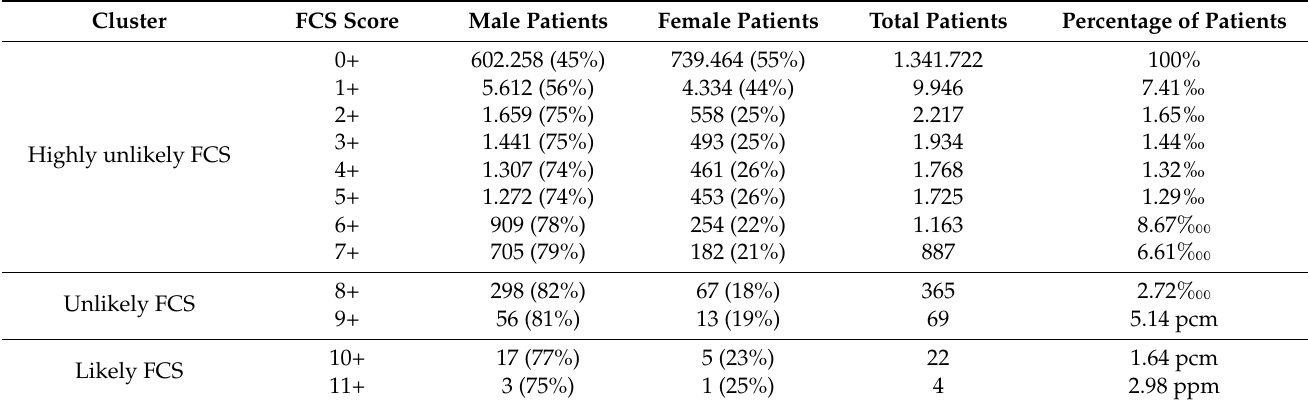
Table 3. Calculated familial chylomicronemia (FCS) scores of patients visiting medical providers in the Northern Great Plain area of Hungary (pcm = 1:100,000; ppm = 1:1,000,000).